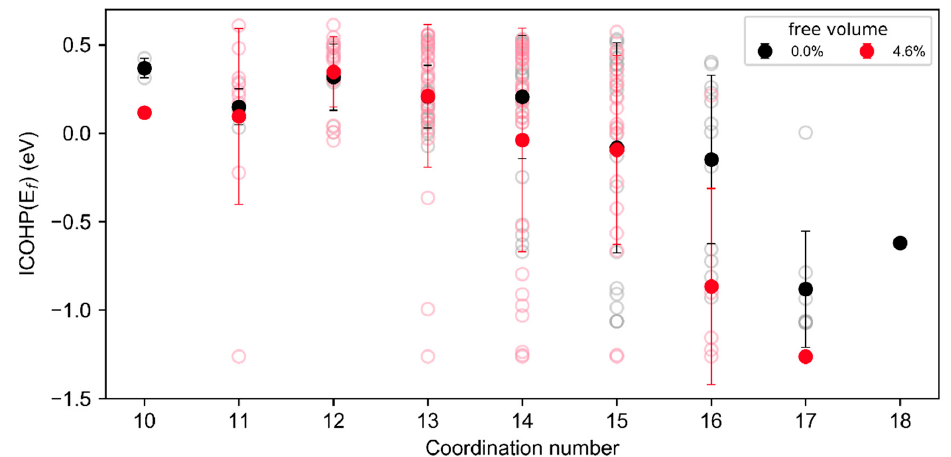
Figure 5. Integrated COHP (ICOHP)(E f ) as a function of the atomic coordination number. Full points mark the mean ICOHP at each coordination number and variability bars indicate plus and minus one standard deviation from the average of all bonds with the respective coordination number. Open symbols mark the ICOHP(E f ) of the individual atoms considered.